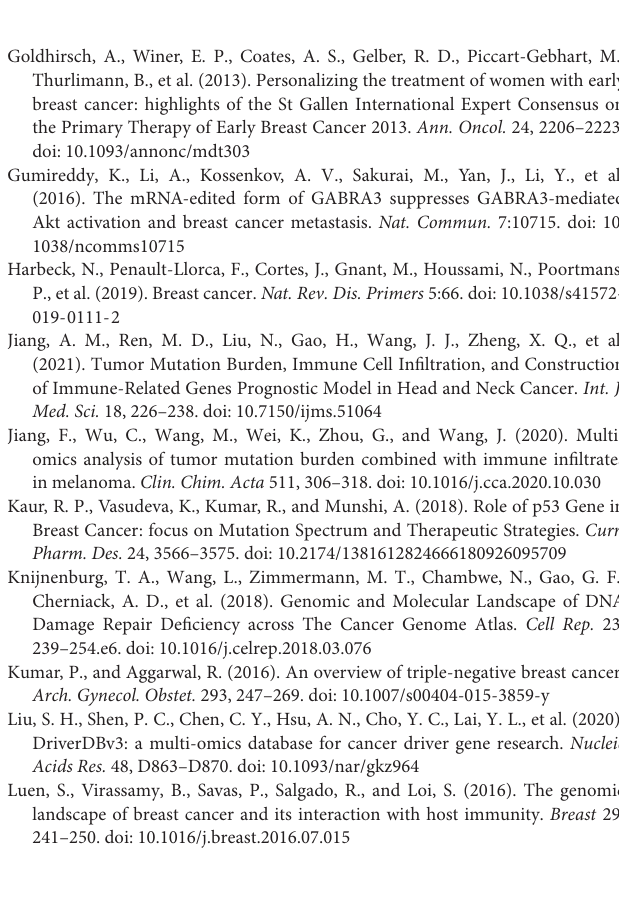
Supplementary Figure 1 | Comparison of specific miRNA expression levels among the breast cancer subtypes. Supplementary Figure 2 | Mutation frequency of key genes in ten classic signaling pathways. The three black dots on the left side of the gene name represent gene mutation, copy number amplification and deletion. The colors represent oncogenes and tumor suppressor genes. The intensity of the color represents the frequency of mutations. Supplementary Figure 3 | Correlation analysis of fibroblast infiltration levels and twenty-two immune cell infiltration levels in different subtypes. Red indicates a positive correlation, and blue indicates a negative correlation. The number represents the degree of correlation, and p < 0.05. Supplementary Figure 4 | Comparison of immune checkpoint gene mRNA expression levels among the breast cancer